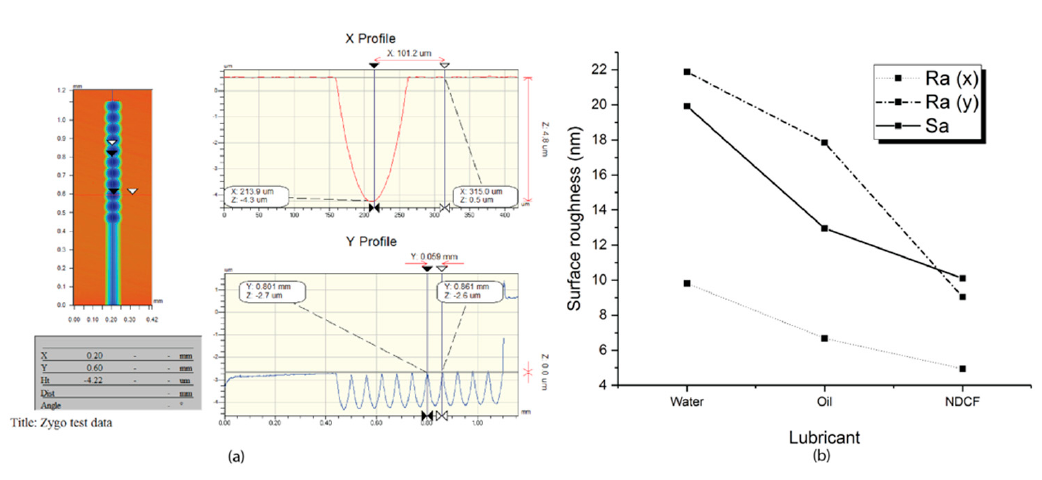
Figure 8. Measurements of single-column microlens arrays. ( a ) cross section profile and dimensions ( b ) surface roughness of microlens.